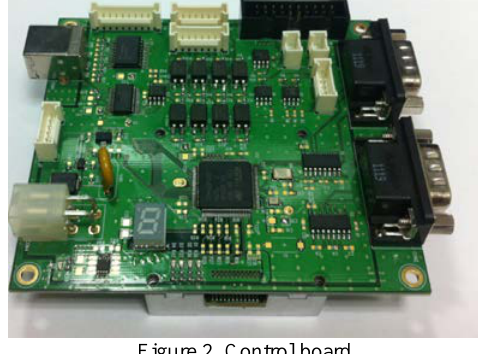
Figure 2. Control board